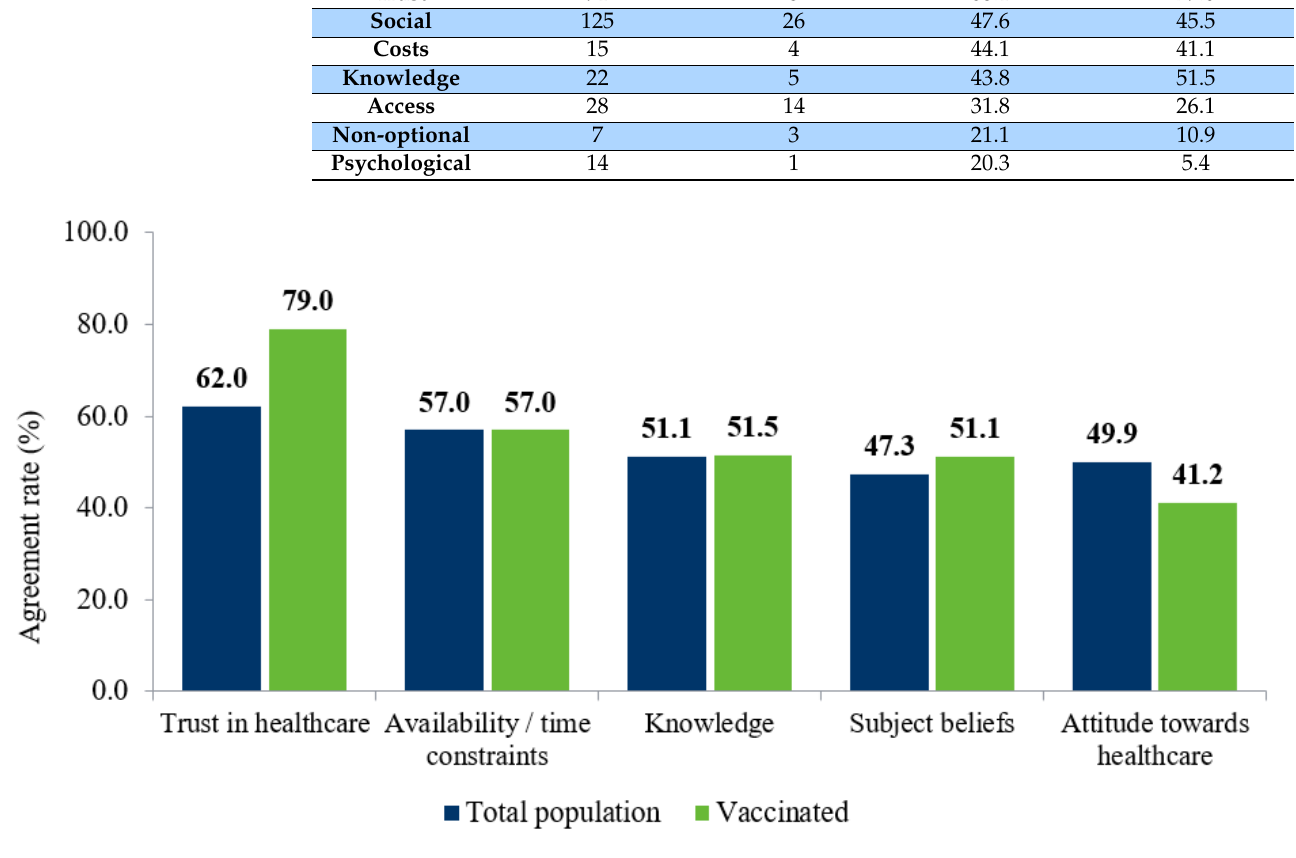
Figure 4. Question types as promoters of vaccination: total versus vaccinated population.